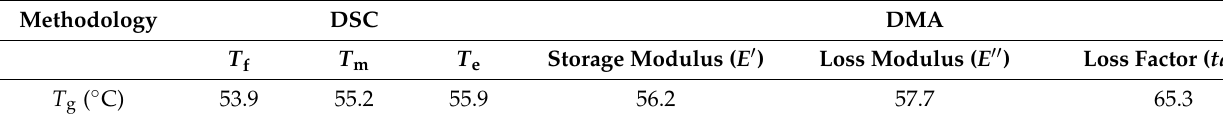
Table 2. Results of DSC and DMA methods.